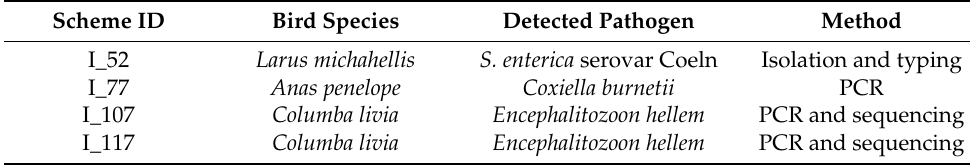
Table 2. Positive results for at least one